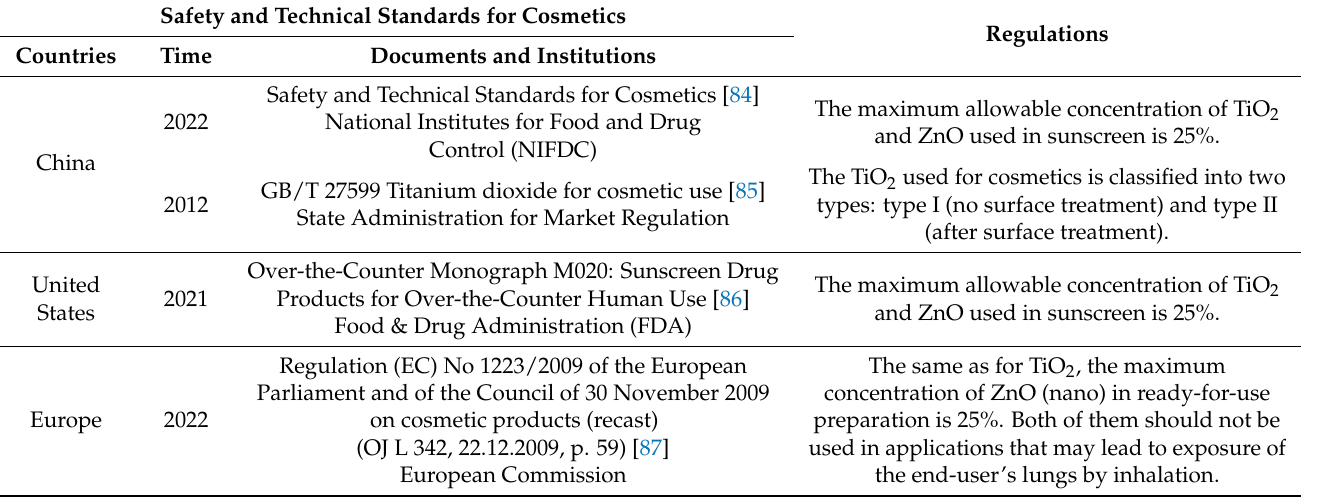
Table 3. A brief review of the safety and technical standards for cosmetics containing ZnO and TiO 2